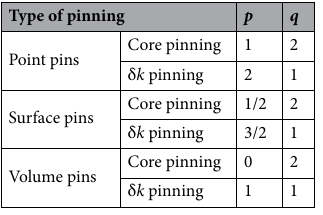
Table 1. Exponents of the pinning